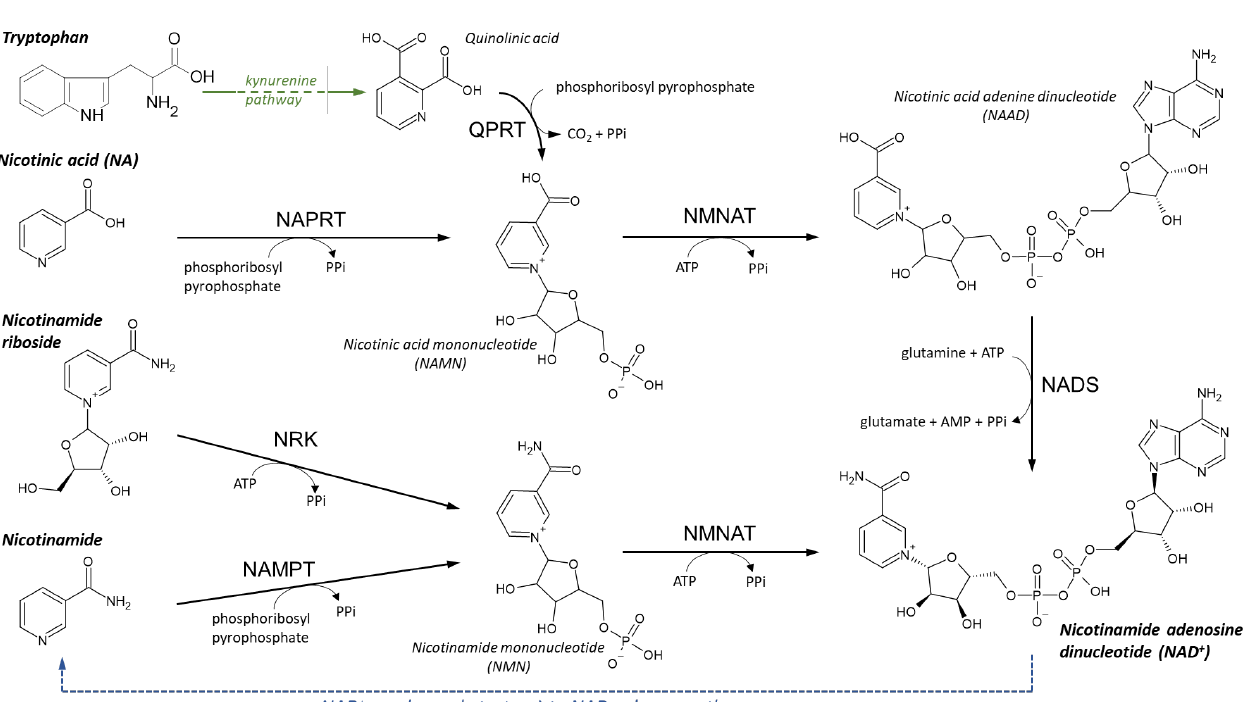
Figure 10. NAD synthesis pathways in mammals. Biochemical reactions involved in production of NAD from dietary sources. The blue arrow indicates activity of NAD + -consuming enzymes and entry of thus released nicotinamide into the salvage pathway. See text for detailed description.